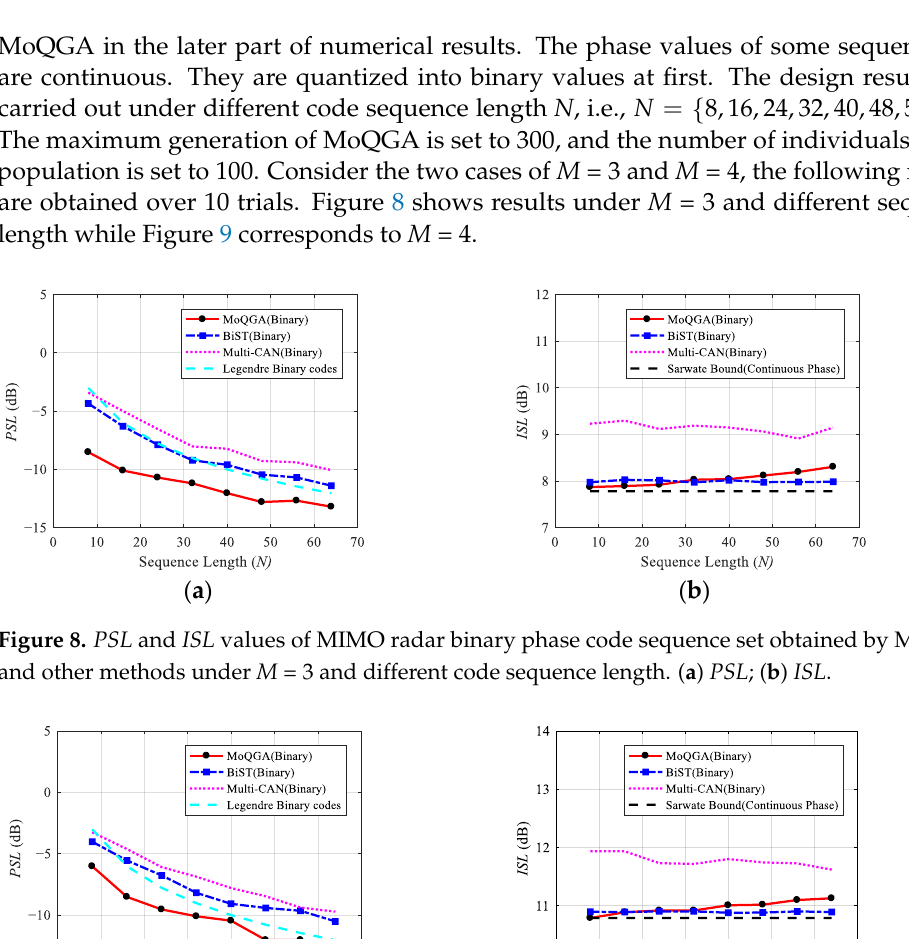
( b ) Figure 10. PSL and ISL values of MIMO radar quaternary phase code sequence set obtained by MoQGA and other methods under M = 3 and different code sequence length. ( a ) PSL ; ( b ) ISL .